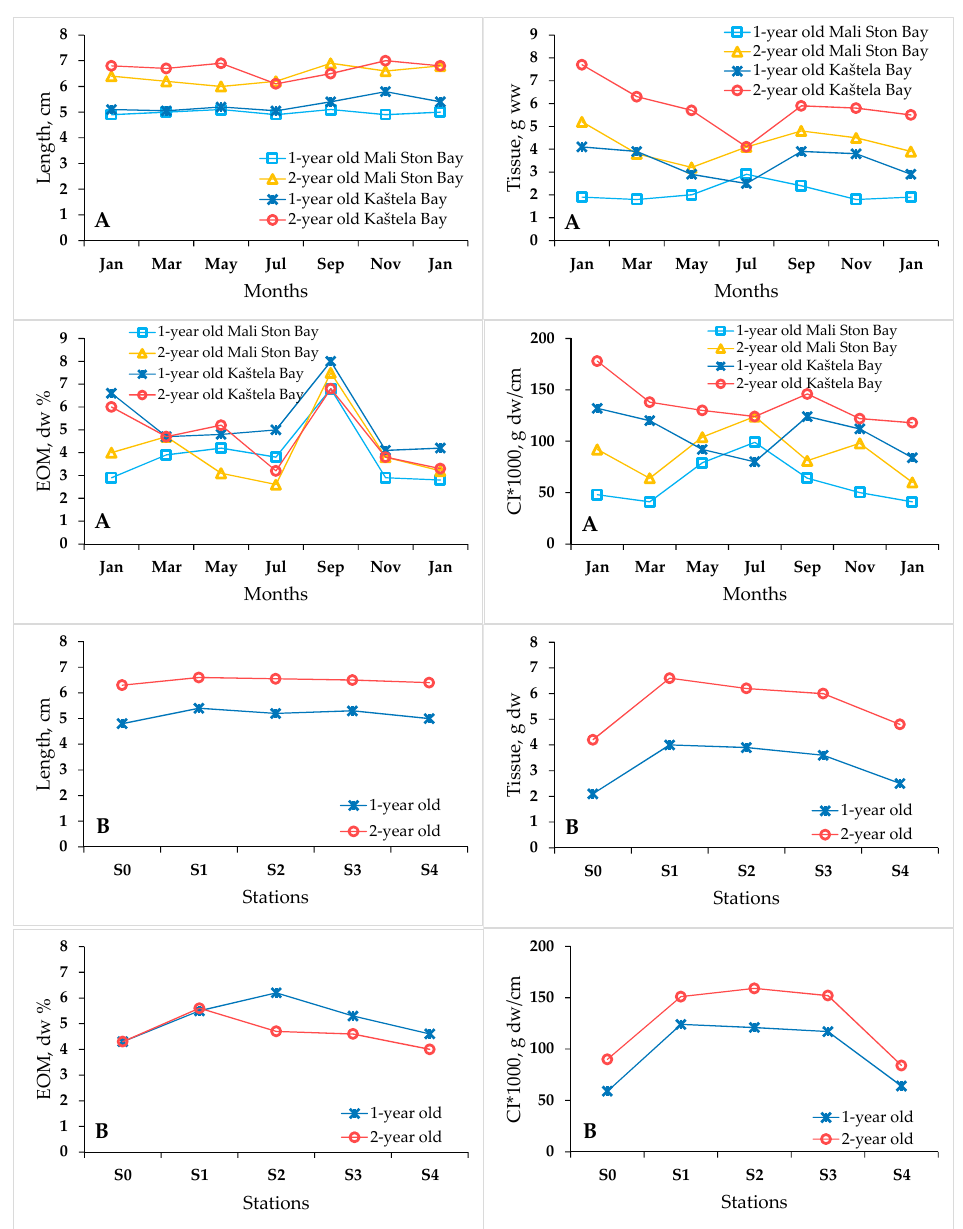
Figure 2. Biological parameters (shell length, tissue weight, lipid content— extractable organic matter (EOM) and condition index (CI)), in 1- and 2-year-old mussels from Mali Ston Bay and the ones transplanted to Kaštela Bay. A—temporal variations; B—spatial variations.